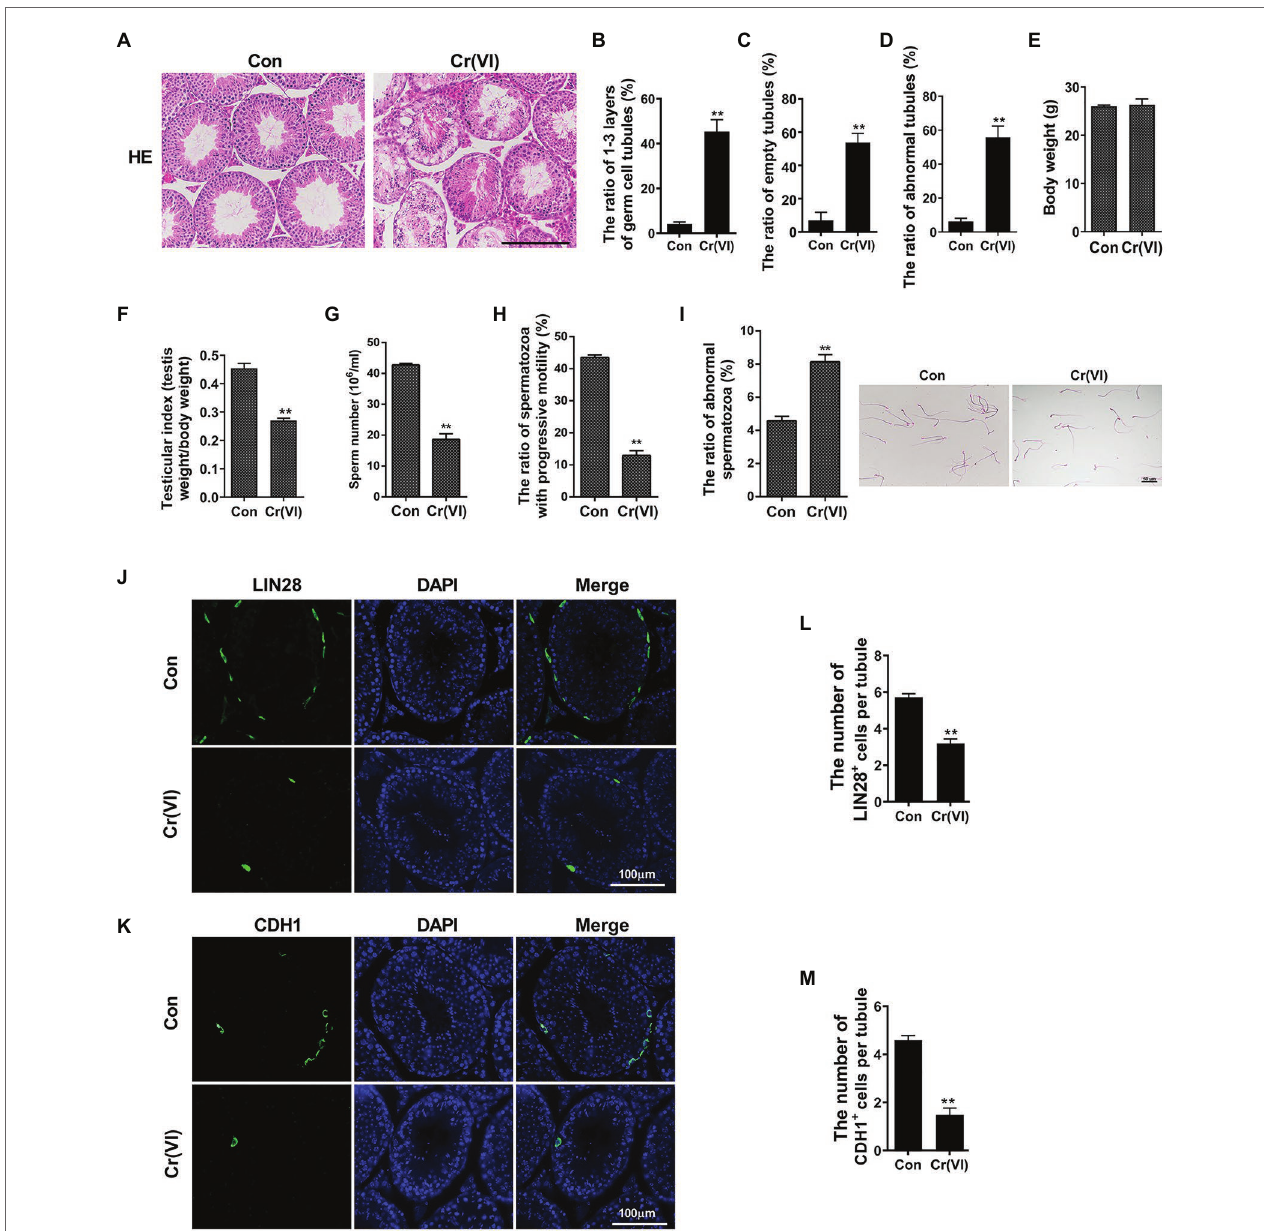
FIGURE 1 | Chromium (Cr) (VI) damaged male reproductive system and spermatogonial stem cells (SSCs)/progenitors in mouse testes. (A) Hematoxylin and eosin (H&E) staining of testis sections from control and Cr (VI)-treated mice. Bar = 200 μ m. (B–D) The ratios of only 1–3 layers of germ cell (B) , empty (C) , and abnormal (D) seminiferous tubules in control and Cr (VI)-treated mouse testes. (E) The average body weight in control and Cr (VI)-treated mice. (F) The average testicular index (testis weight/body weight) in control and Cr (VI)-treated mice. (G) The average sperm number (10 6 /ml) in control and Cr (VI)-treated mice. (H) The ratio of spermatozoa with progressive motility in control and Cr (VI)-treated mice. (I) Left: the ratio of abnormal spermatozoa in control and Cr (VI)-treated mice; Right: images of spermatozoa from the control and Cr (VI)-treated mice. Bar = 50 μ m. (J,K) Immunofluorescence staining for LIN28 (J) and CDH1 (K) in testis sections from control and Cr (VI)-treated mice. Bar = 100 μ m. (L,M) The numbers of LIN28 + (L) and CDH1 + cells (M) per seminiferous tubule in control and Cr (VI)-treated mouse testes. Data are presented as the mean ± SEM from five mice, and 300 seminiferous tubules from five mice were analyzed in each group. ** p <